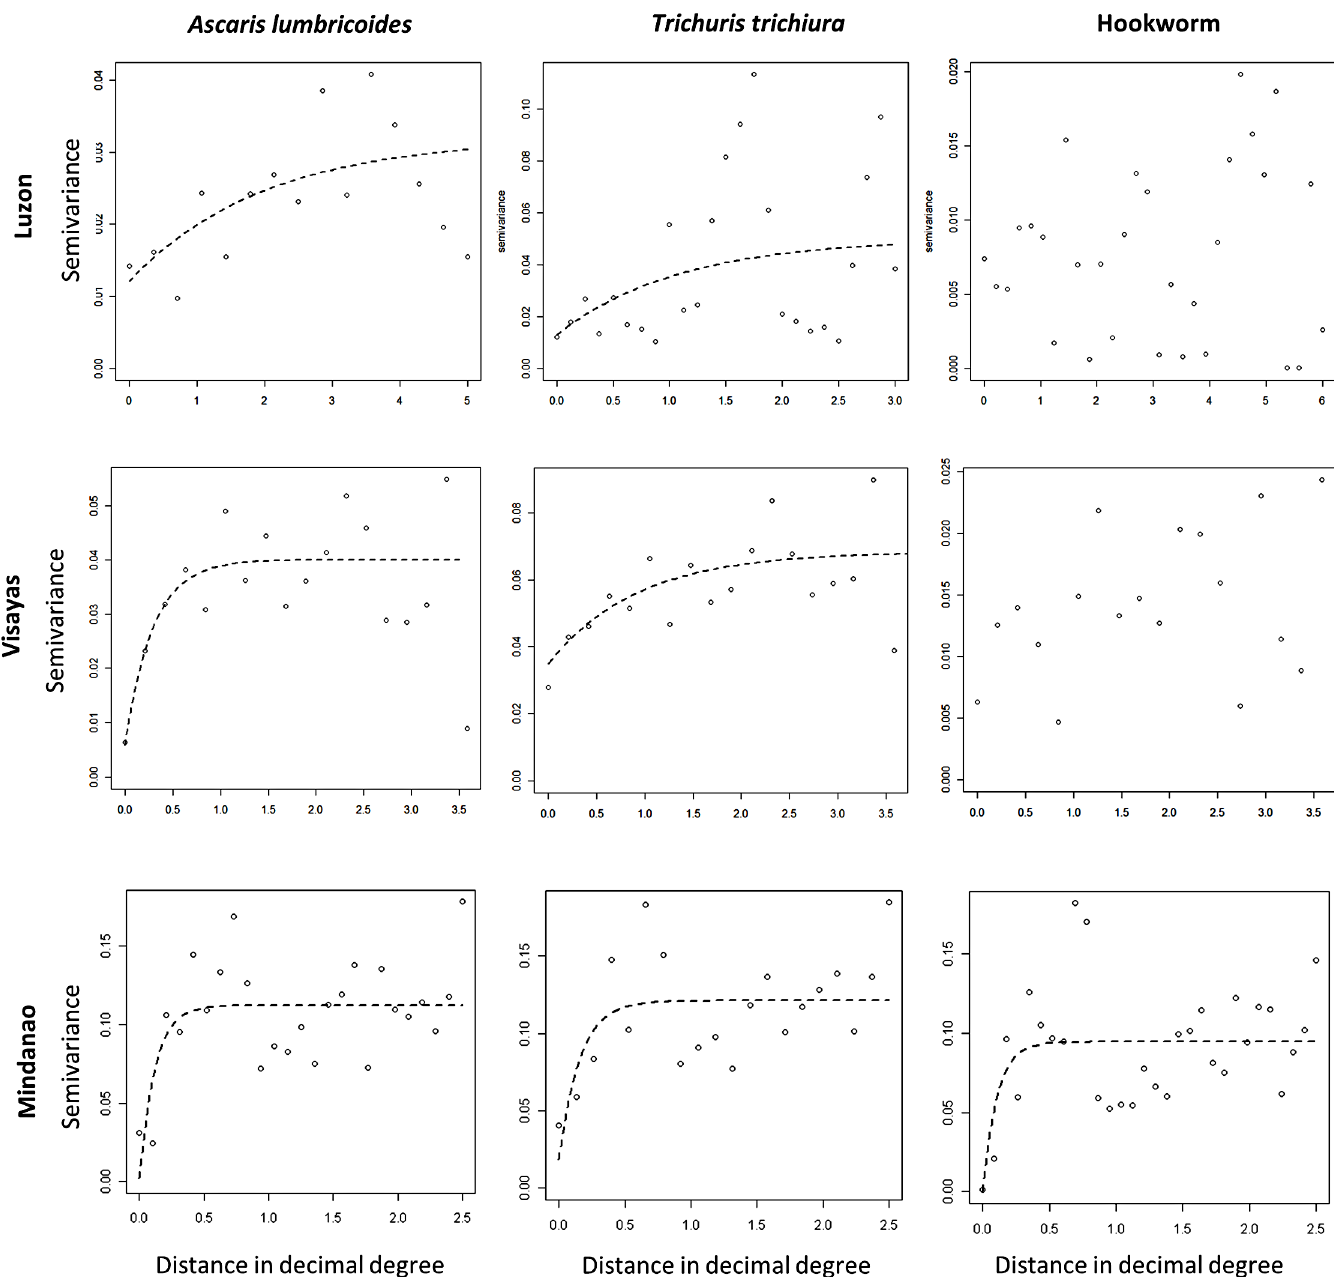
Fig 2. Residual semivariograms for Ascaris lumbricoides , Trichuris trichiura and hookworm in Luzon, the Visayas and Mindanao. Note: distance is recorded in decimal degrees (1 decimal degree is 111km at the equator).